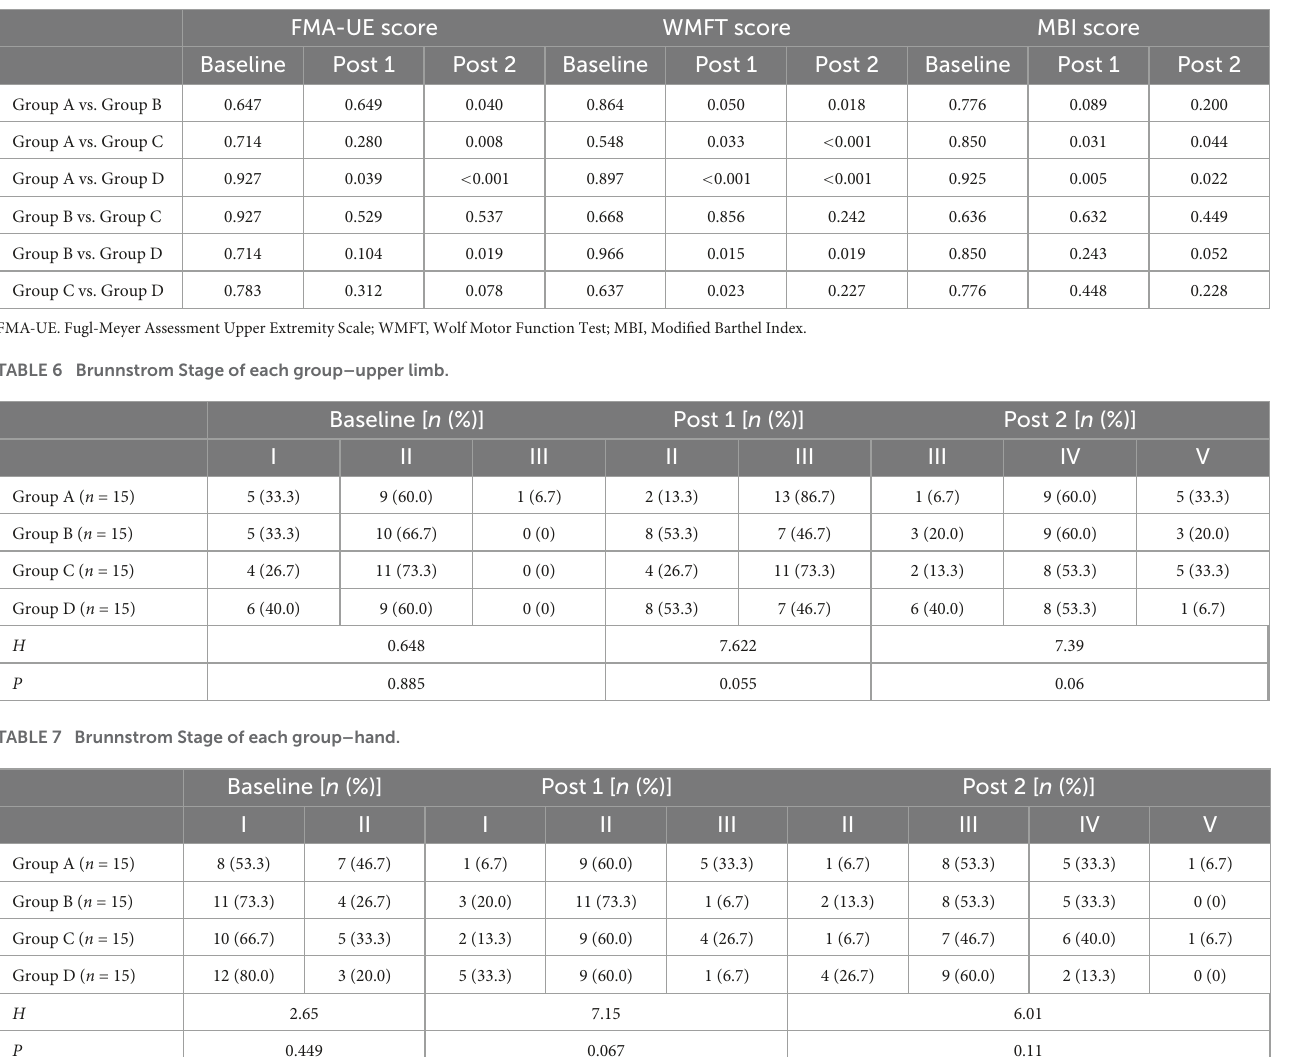
TABLE 5 P- values for the comparisons of FMA, WMFT, and MBI score in the four groups at different evaluation time points.